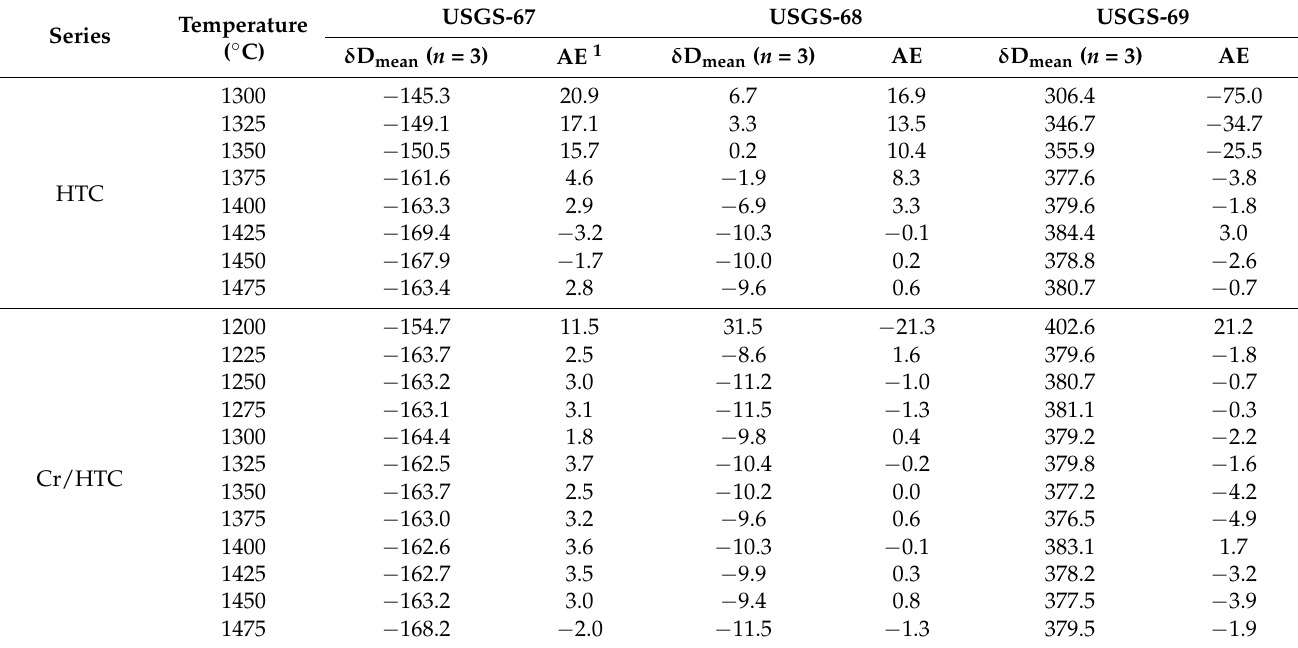
Table 1. Measured δ D values and absolute errors of RMs using the HTC and Cr/HTC methods.